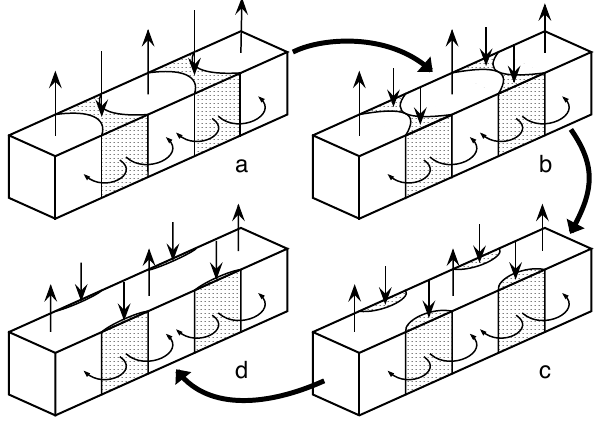
Figure 8. Stripe and channel domain